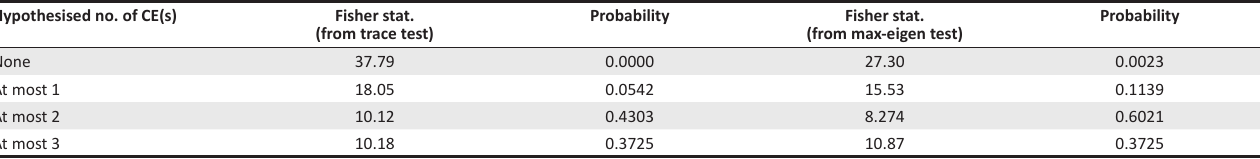
TABLE 3e: Johansen Fisher panel cointegration tests. Hypothesised no. of CE(s) Fisher stat.